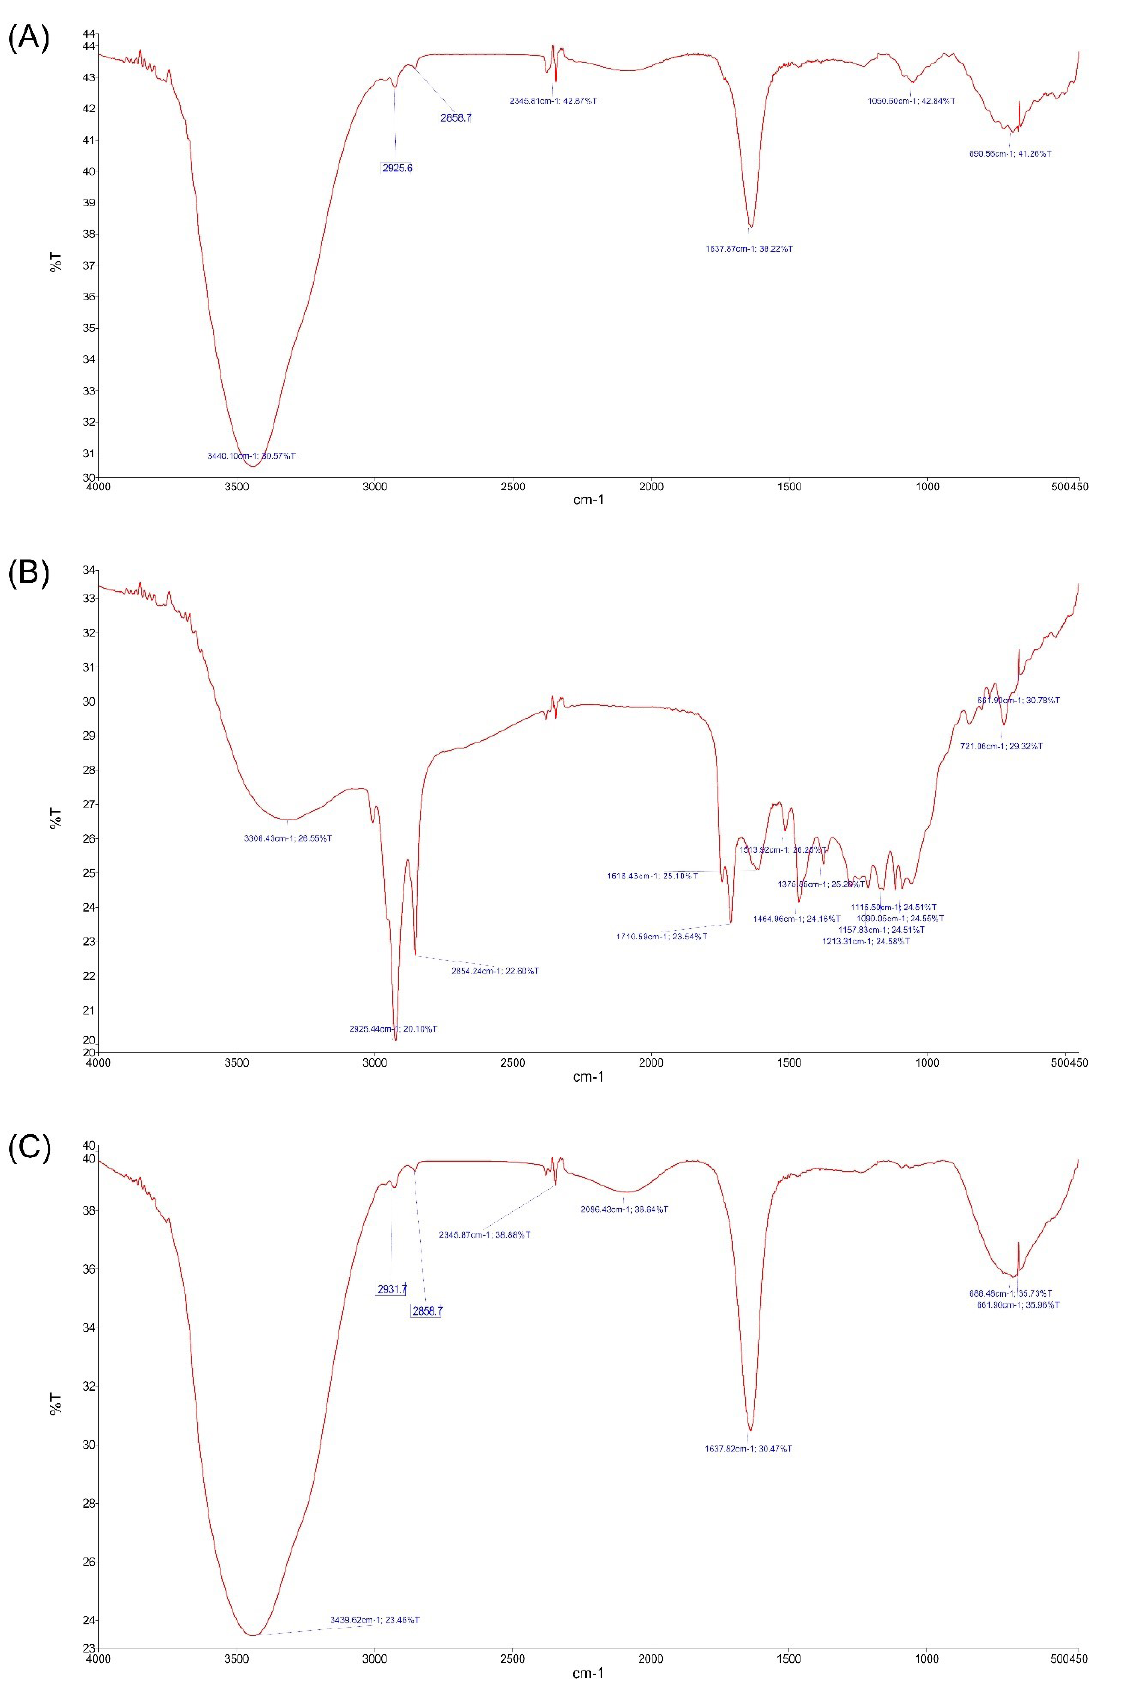
Figure 8. Spectra Obtained From the Study by the FTIR Device: (A) Empty Synthesized Liposome, (B) Licorice Extract, and (C) Liposome Containing the Licorice Extract. Note . FTIR: Fourier-transform infrared